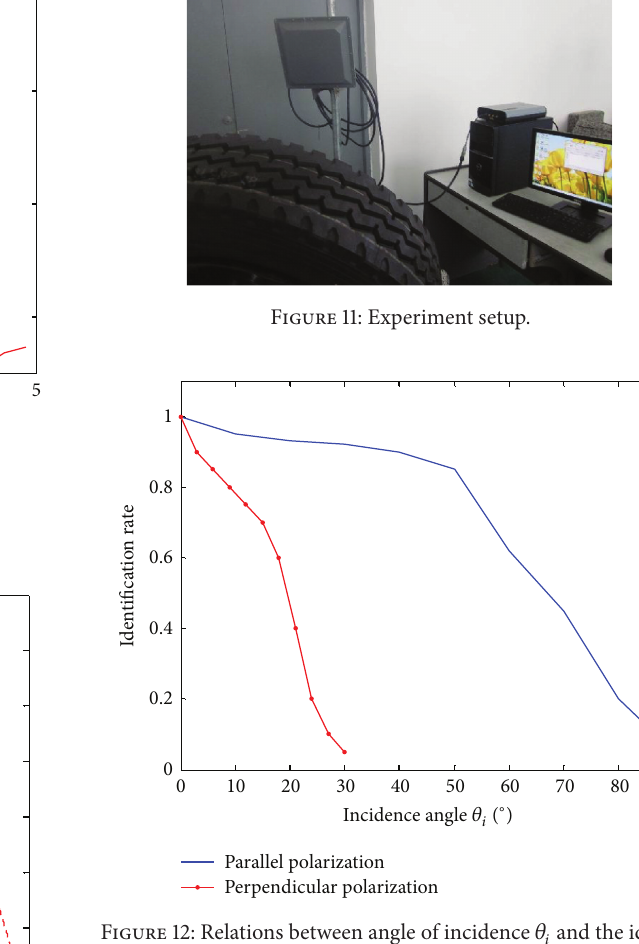
Figure 12: Relations between angle of incidence 𝜃 𝑖 and the identifi- cation